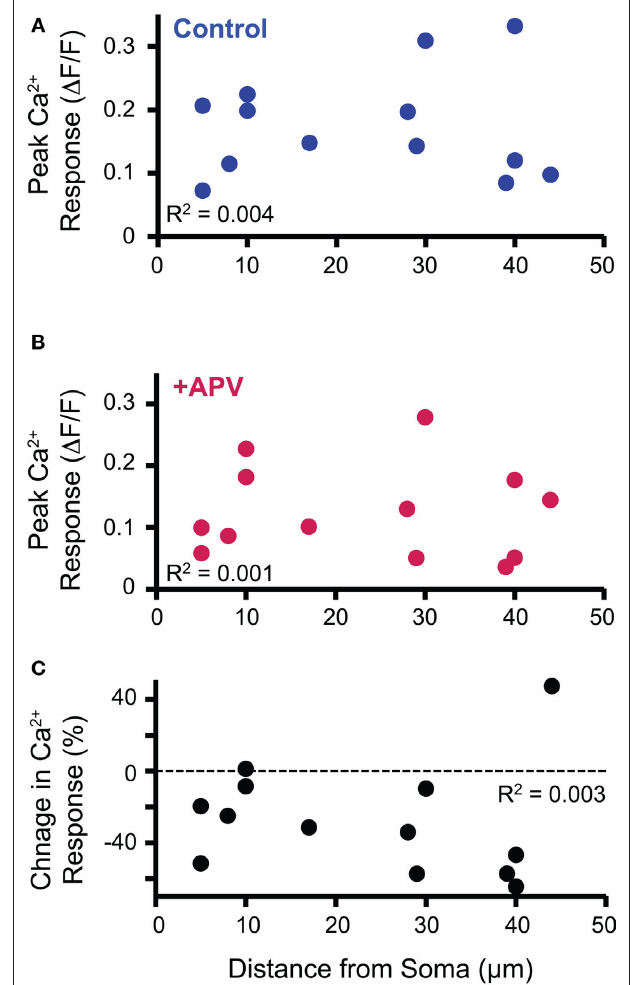
FiGUre 4 | Soma-dendritic distance of imaged dendritic Ca 2 + response did not correlate with peak response in control (A) or APV (B)